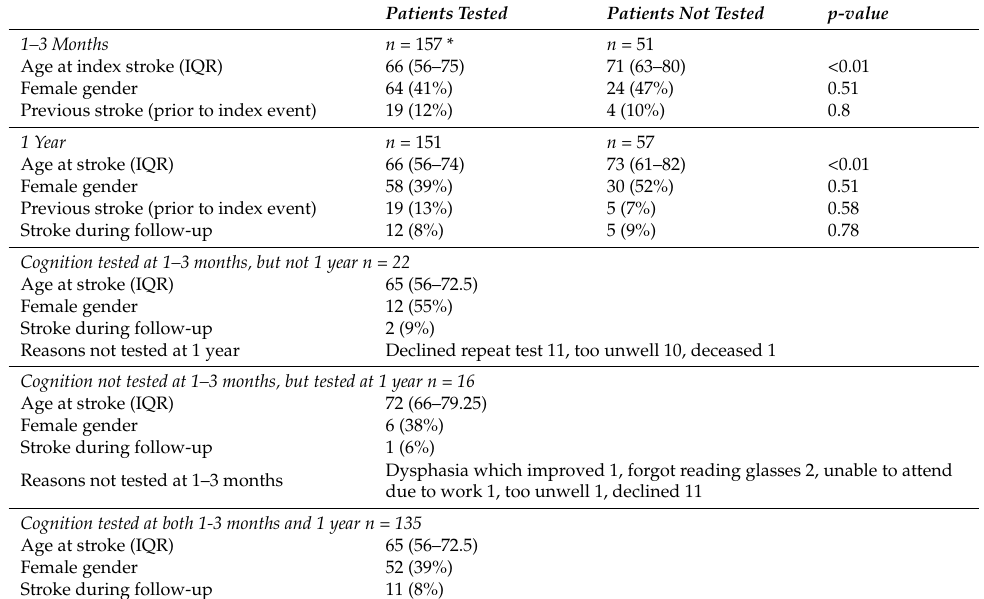
Table A2. Demographics of patients who had cognitive testing vs. those recruited but who did not undergo cognitive